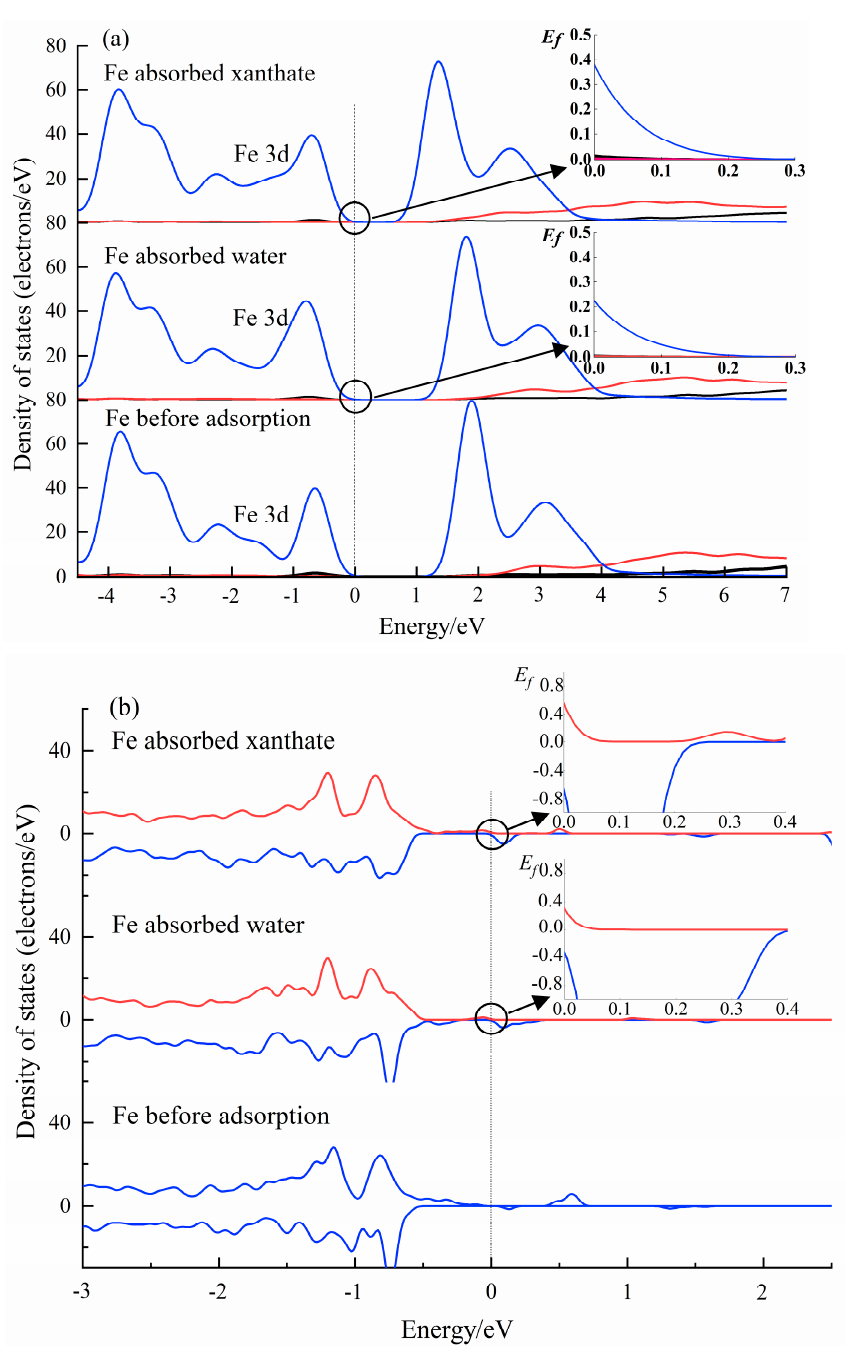
Figure 9. The calculated PDOS results of Fe 3d state in Fe(OH) 2 ( a ), and FeCO 3 ( b ) surface before and after the adsorption by adsorbents.